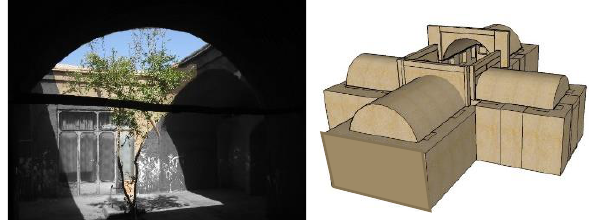
Figure 5. Shading by the sofe in the central courtyard and four numbers of sofe in the chahar-sofe house.